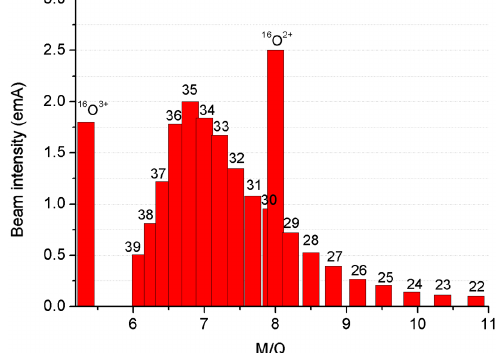
FIG. 9. Charge state distribution of the initial mixed beam ( 238 U and 16 O) in the simulation.